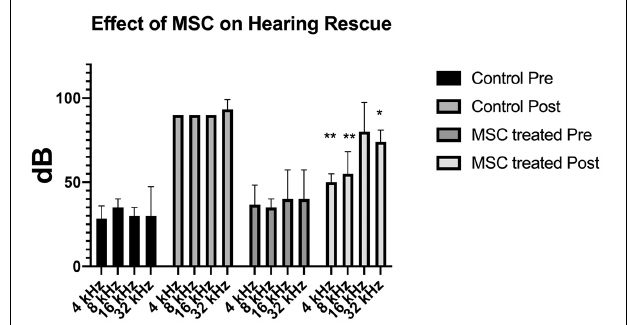
FIGURE 2 | Delivery of MSCs rescue hearing after noise exposure. Exposure to sound for 4 h results in a profound hearing loss across all frequencies (medium gray bars; Control Post). Delivery of MSCs into the posterior semicircular canal of animals after sound exposure resulted in significant rescue of hearing at 4 and 8 kHz ( p < 0.01**) as well as at 32 kHz ( p < 0.05*) (light gray bars; MSC treated Post) when compared to the control animals treated with artificial perilymph (Control Post).